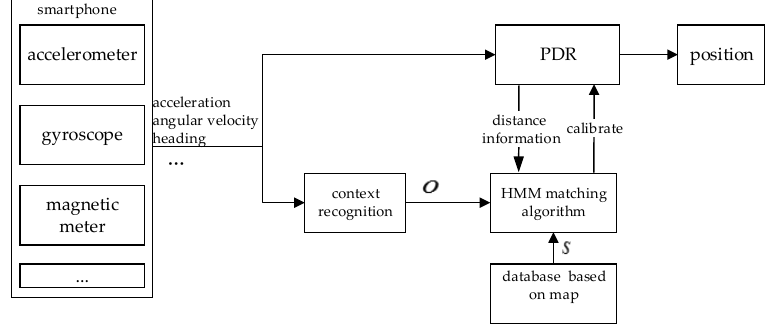
Figure 1. The diagram of the proposed method.